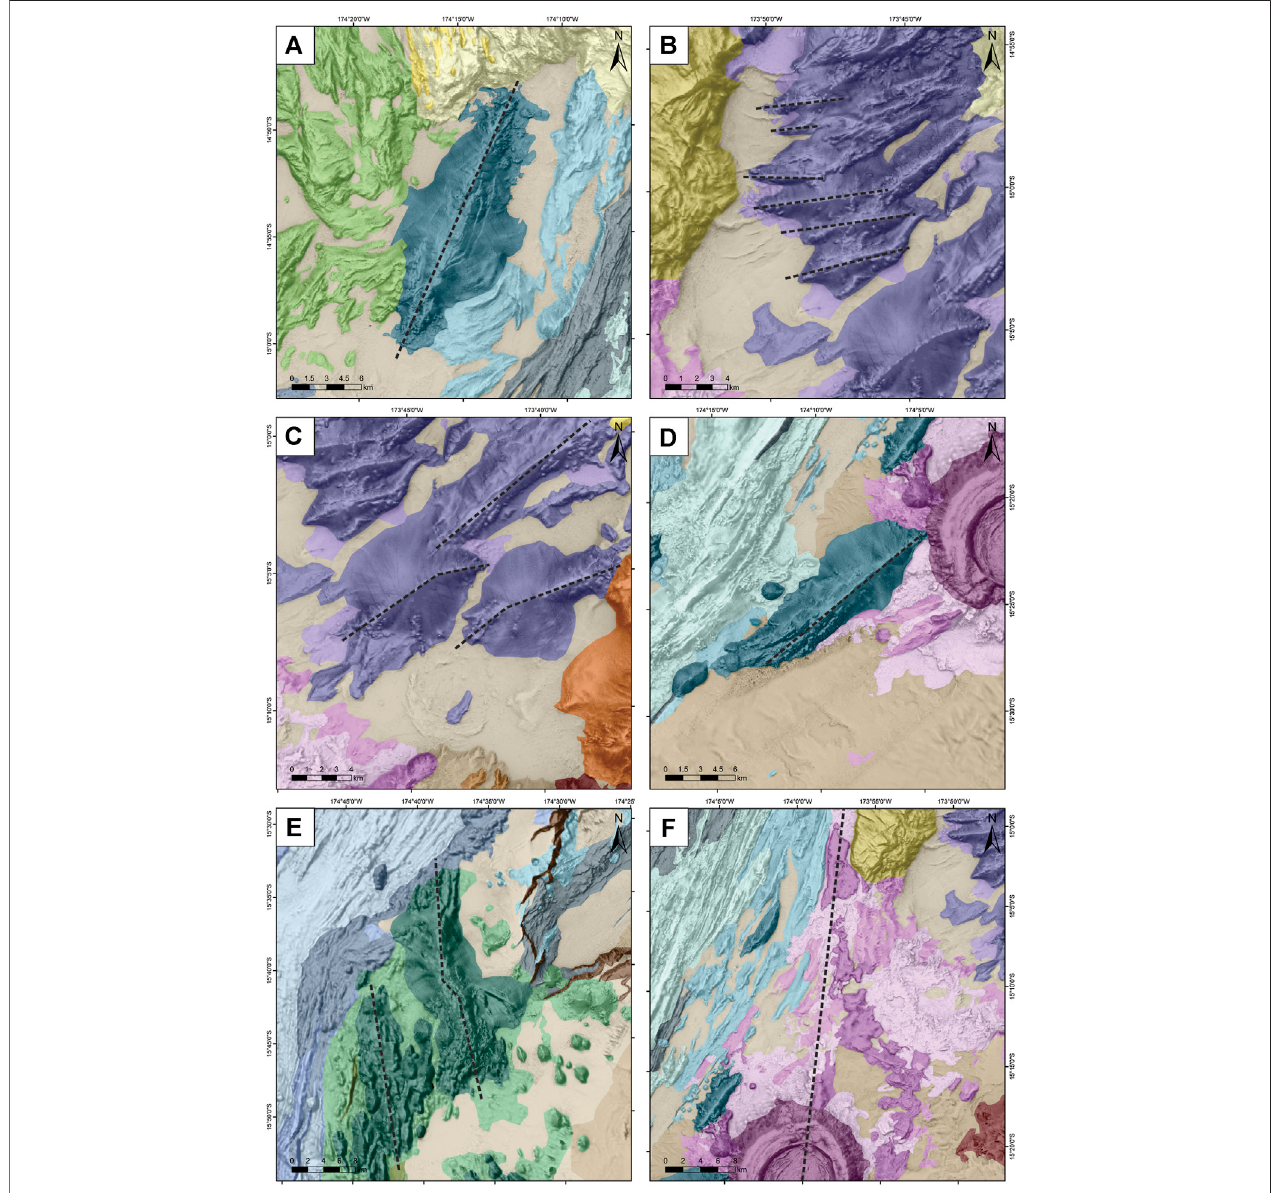
FIGURE 11 | Examples of large off-axis volcanic ridges/ fi ssures in the study area aligned along different orientations: (A) NNE-trending ridge located northwest of the NELSC; (B) E-trending ridges of the northern Mata volcanoes; (C) ENE-trending ridges of West Mata and East Mata volcanoes; (D) ENE-trending ridge located southwest of Niuatahi; (E) N-trending ridges north of the FRSC; and (F) small N-trending ridge and fi ssure system north of Niuatahi. Bathymetric compilation as in Figure 3 , geology map follows the legend in Figure 5 .